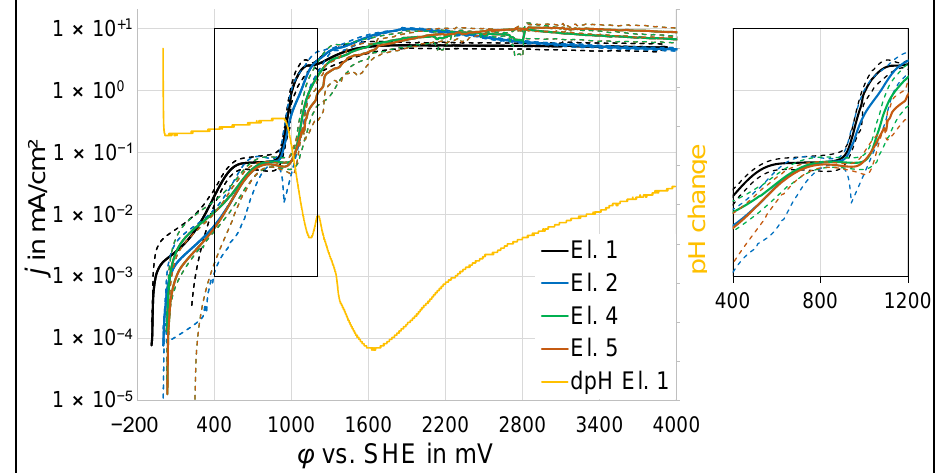
Figure 2. j – ϕ curves due to potentiodynamic polarization in electrolytes (El.) 1, 2, 4, and 5 within the range of ϕ corr to OCP + 4 V with a magnified image of the section between 400 and 1200 mV vs. SHE (right) and qualitative pH change (dpH) during a measurement in electrolyte 1 (linear scale). The dashed lines represent the standard deviation between the repetition samples.